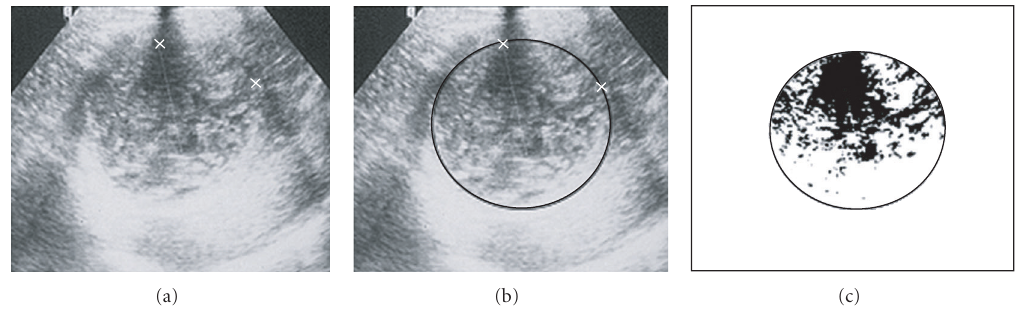
Figure 8: The same cyst of Figure 7, one month after (75% solidification).